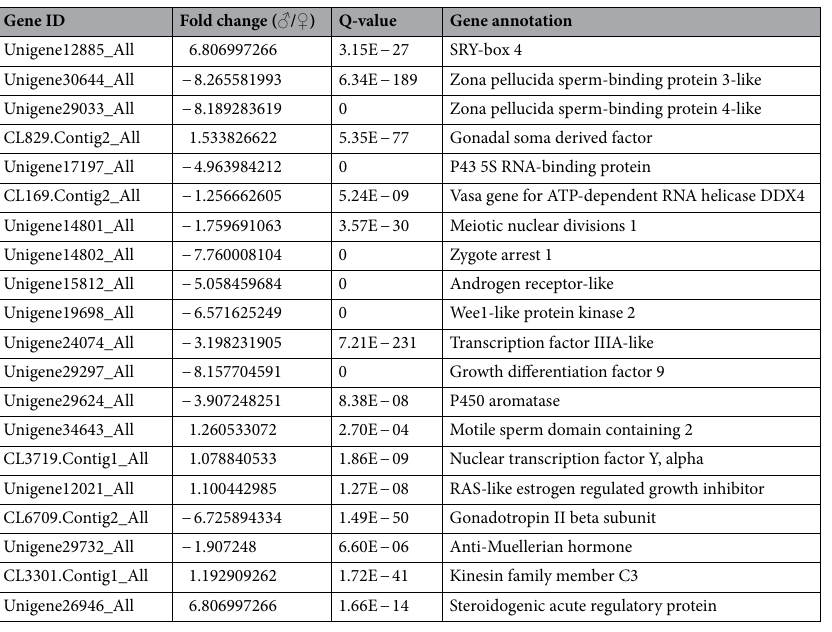
Table 4. Identified sex-related genes in this study.